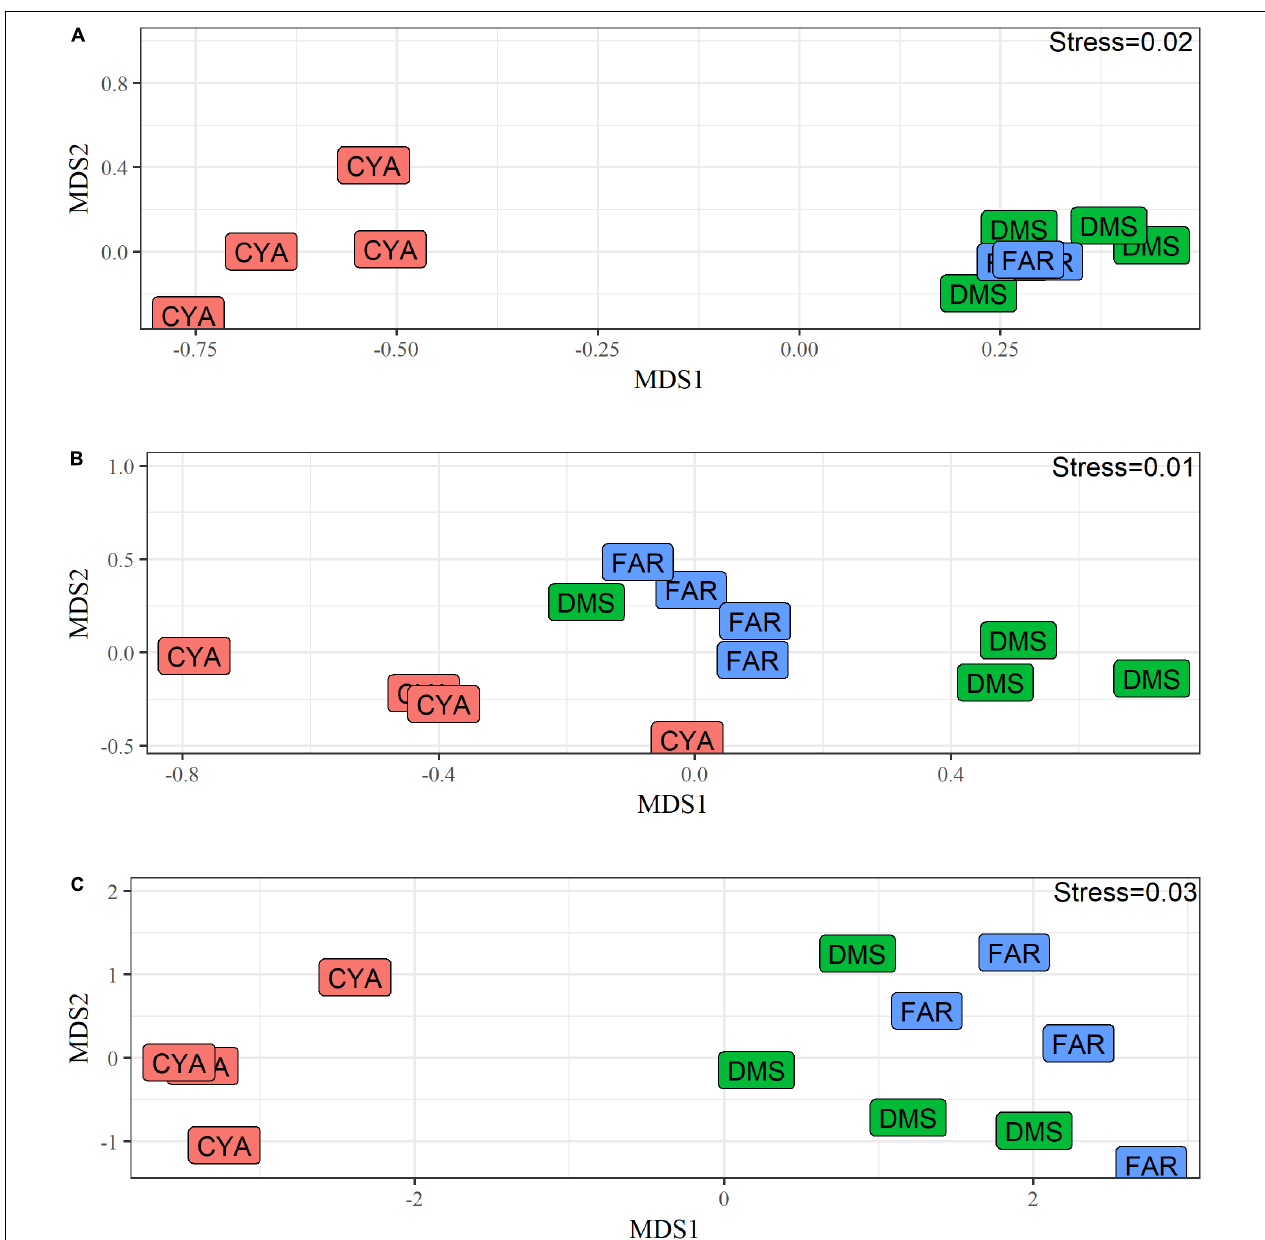
FIGURE 4 | Non-metric Multidimensional Scaling (MDS) of benthic cover (A) , proxies of structural complexity (B) and biomass of fish assemblages (C) . Similarity matrix for benthic and fish assemblage were built using Bray–Curtis index, while Euclidean distances were used for complexity proxies. Note that benthic and fish data were square root transformed and complexity proxies were